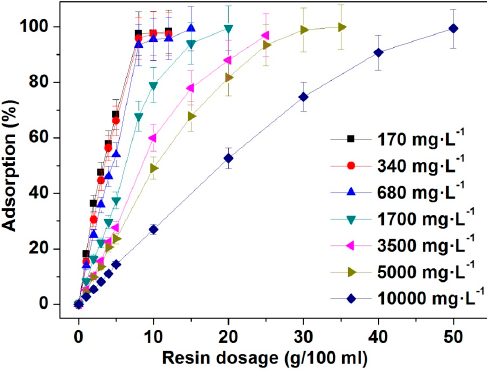
Figure 3. Iron adsorption by resin Rexp-501 at pH 1.0, 298 K and 150 rpm for 90 min.